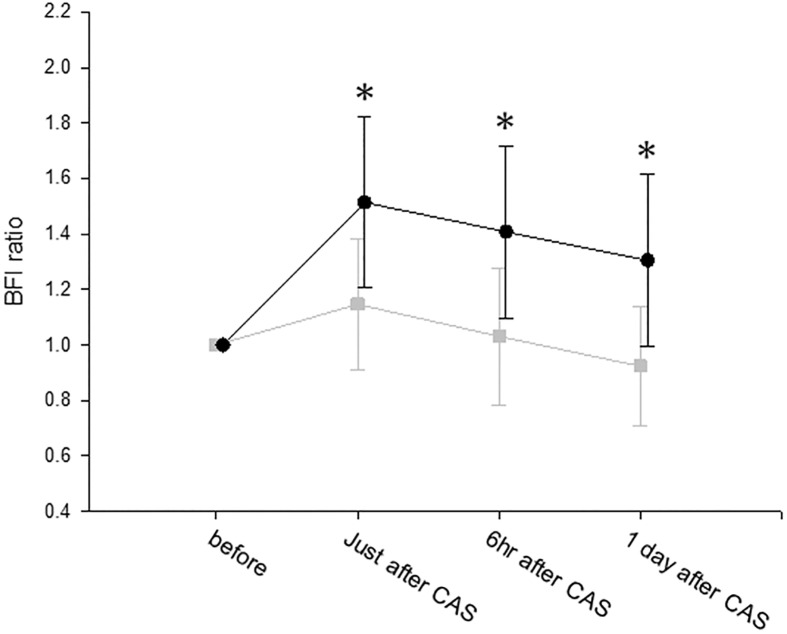
The time course of BFI between the hyperperfusion (HP) group and the non-hyperperfusion (non-HP) group.Black circles indicate the HP group, and gray squares indicate the non-HP group. *P < 0.05.